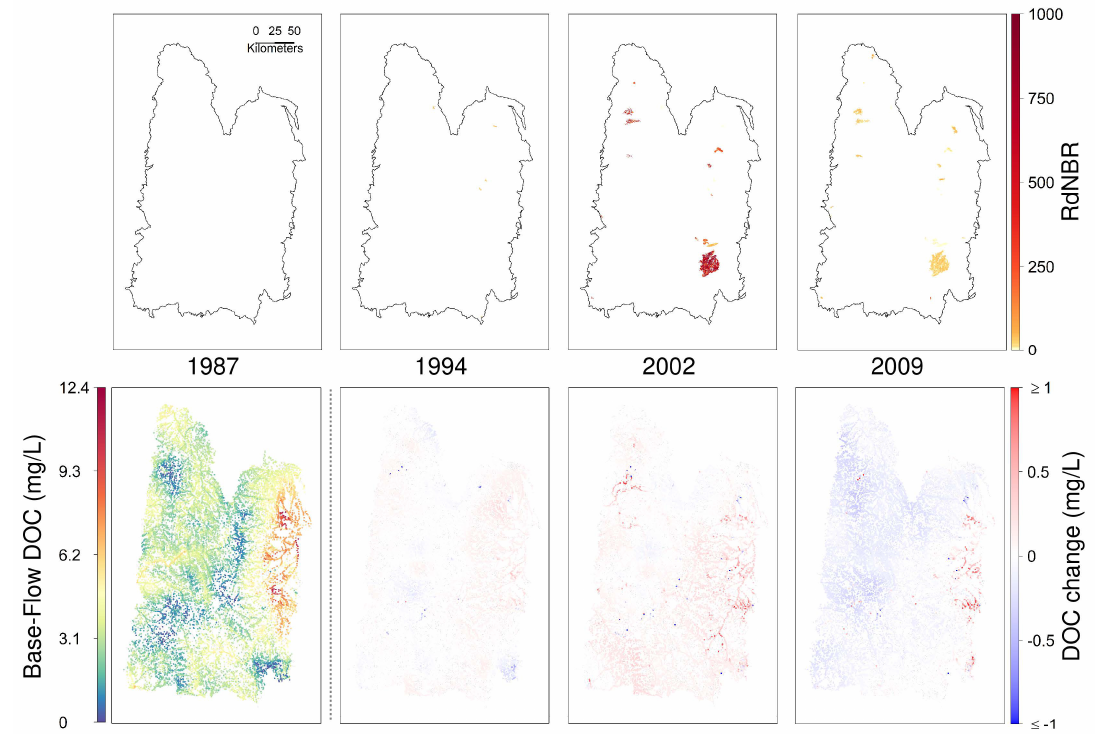
Figure 8. Comparison of fire severity and predicted base-flow DOC concentrations in the region of interest for the years 1987, 1994, 2002, and 2009. Instead of presenting the DOC concentrations for 1994, 2002, and 2009, the difference between their concentrations and the concentrations in 1987 are displayed to facilitate visualization. Although localized points reach RdNBR values of up to 13,000, these are not common, so the color scale used for RdNBR has an upper bound of 1,000 to facilitate